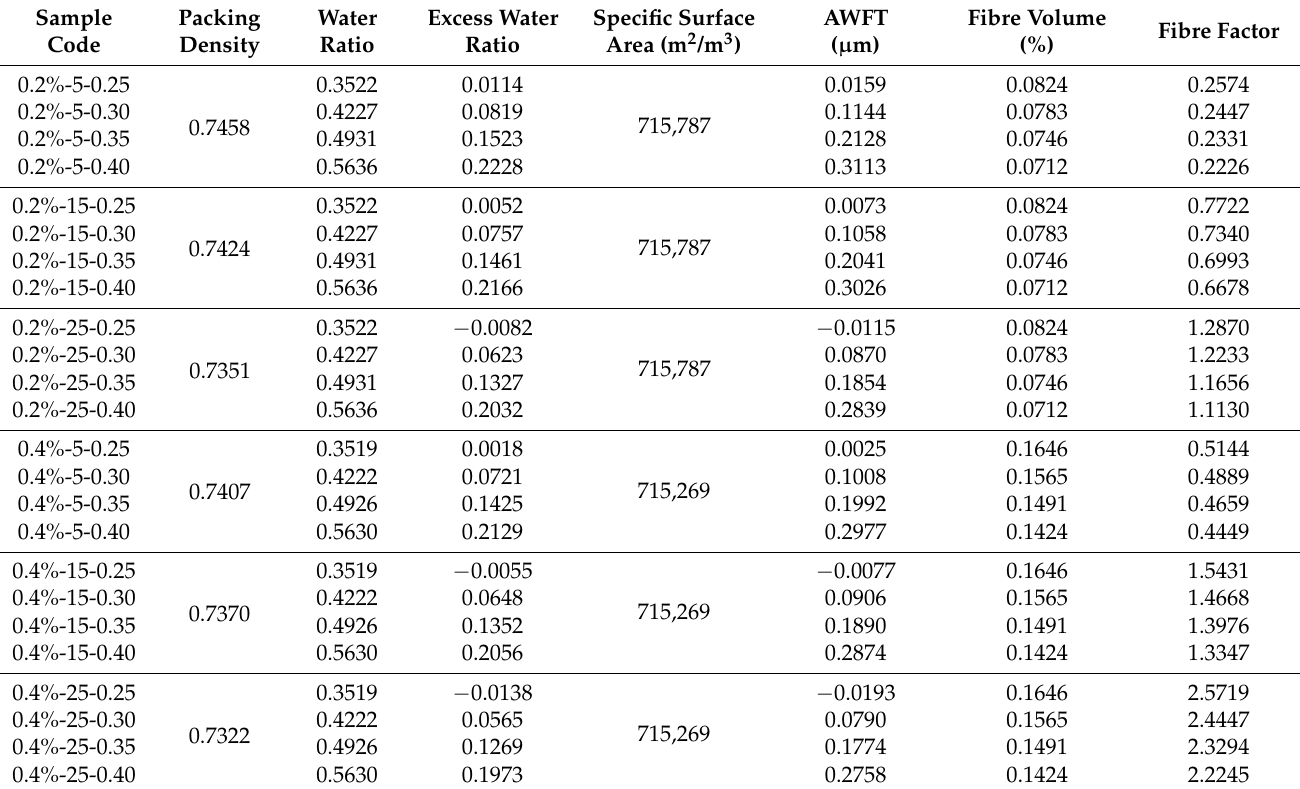
Table 8. Packing density and AWFT of mortar samples with varying fibre dosage and varying